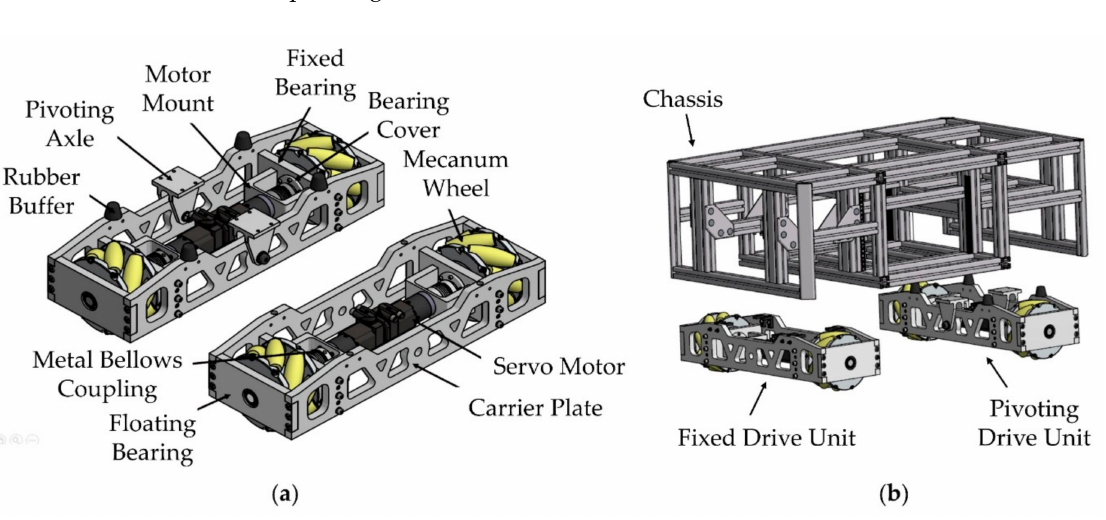
Figure 2. Mechanical components of the mobile platform. ( a ) Drive units; ( b ) drive units positioned at chassis.